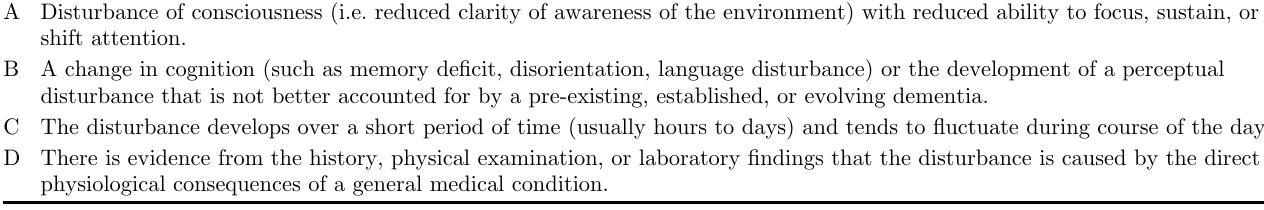
Table 1. Diagnostic criteria for delirium according to DSM-IV [7]. A Disturbance of consciousness (i.e. reduced clarity of awareness of the environment) with reduced ability to focus, sustain, or shift attention.